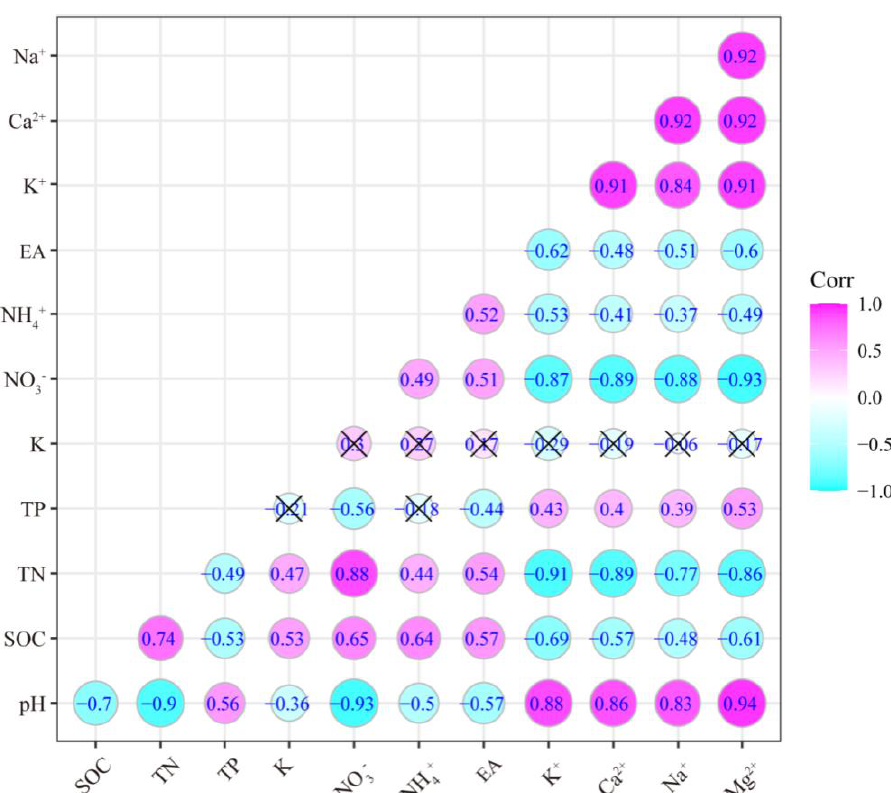
Figure 4. The correlation among soil parameters by Pearson’s correlation test. “Cyan” indicates negative correlations and “magenta” indicates positive correlations. The circle size is proportional to the Pearson’s coefficient. A cross means statistical insignificance ( p > 0.05).